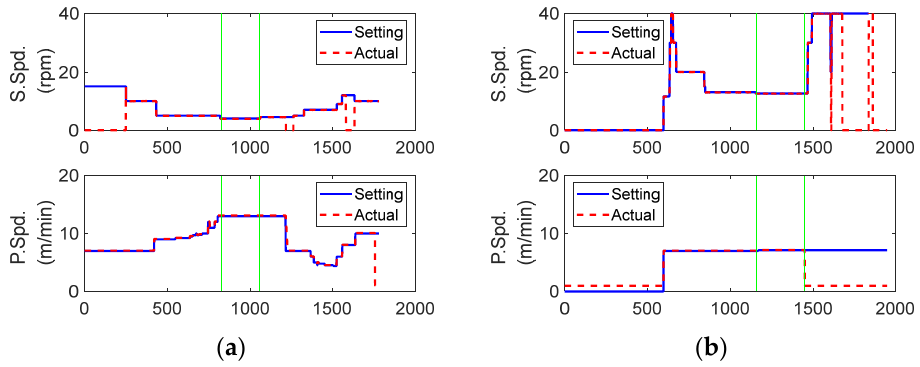
Figure 6. Difference between setting and actual speeds (Maddock): ( a ) data monitored on the first day (6 July 2020); ( b ) data monitored on the last day (25 March 2022).